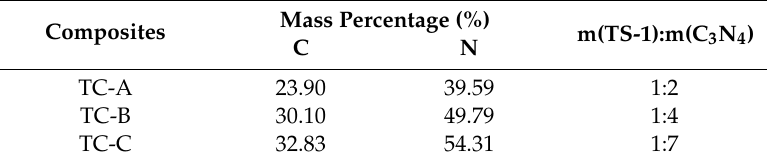
Figure 1. XRD patterns ( a ) and FTIR spectra ( b ) of all the materials. Table 1. The C and N elemental analysis data in